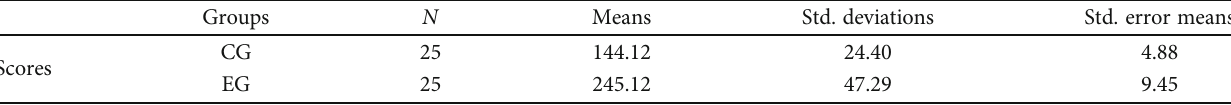
Table 8: Descriptive statistics of the motivation posttests.